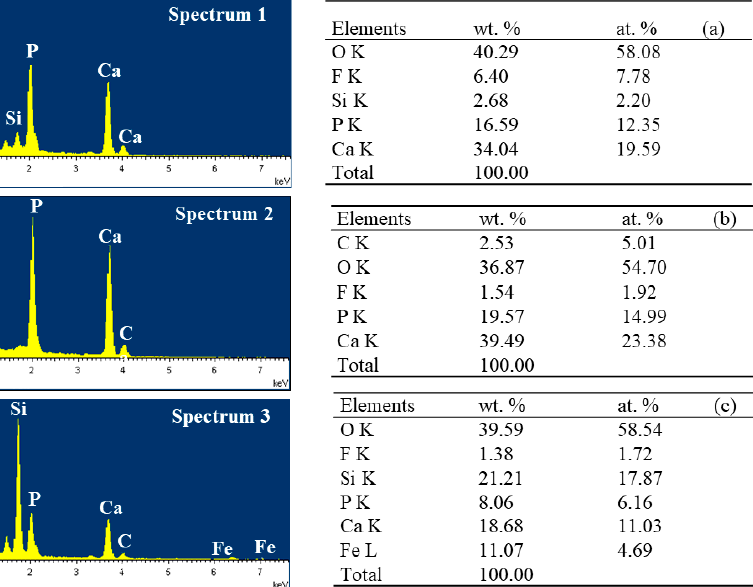
Figure 7. Energy dispersive X-ray spectroscopy (EDS) images of three PR powders and their elemental compositions.